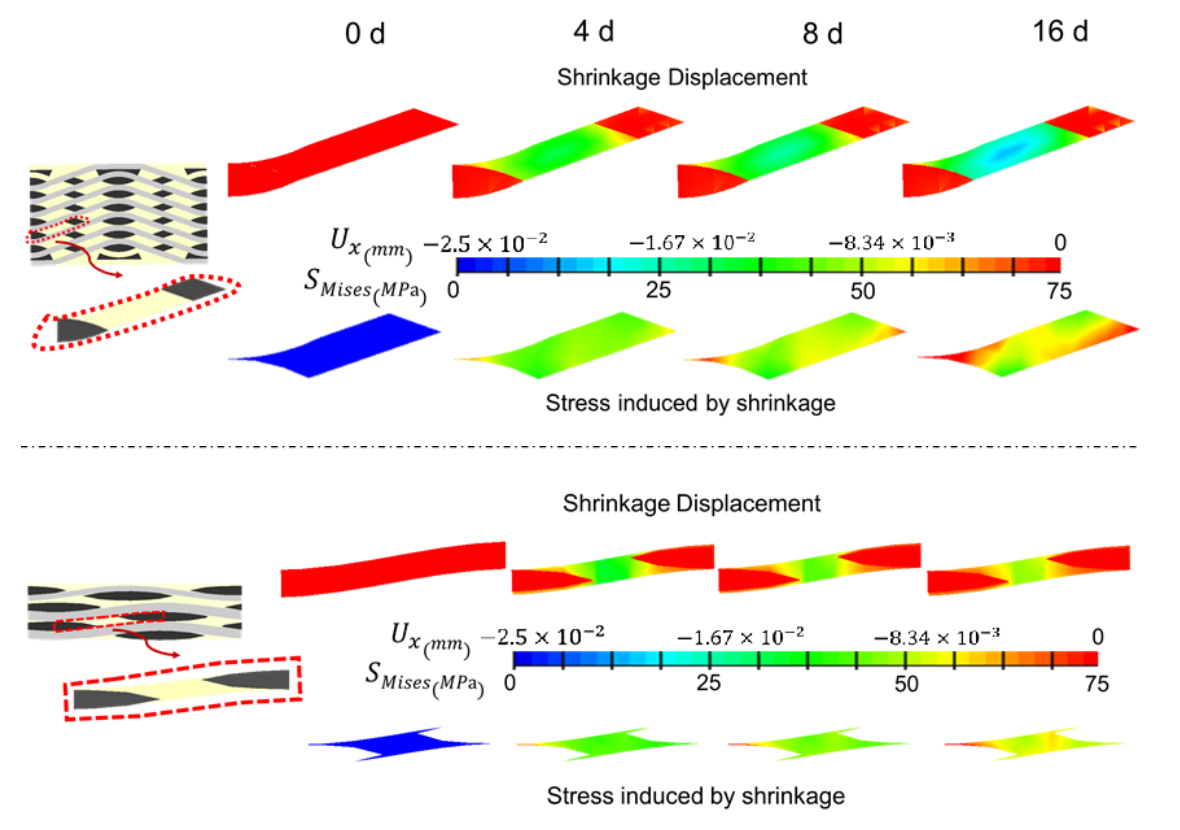
Figure 10. Local shrinkage and internal stress in PWC and AWC with different ageing time.